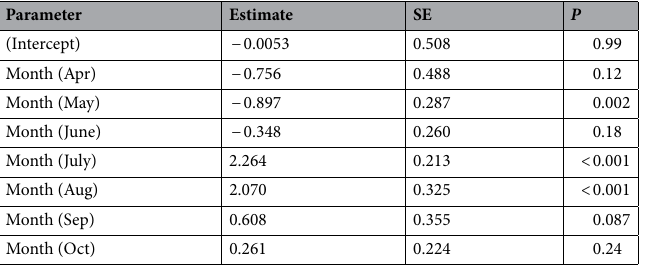
Table 1. Summary (coefficient) of the selected generalized linear mixed model (binomial family and logit-link function) for female (0) or male (1) of crawling Laguncula pulchella individuals with shell height ≥ 25 mm. The initial explanatory variables were month and binomial day or night, but the binomial day or night was eliminated from the model based on the Akaike information criterion (AIC). The effect of month was evaluated based on "March".